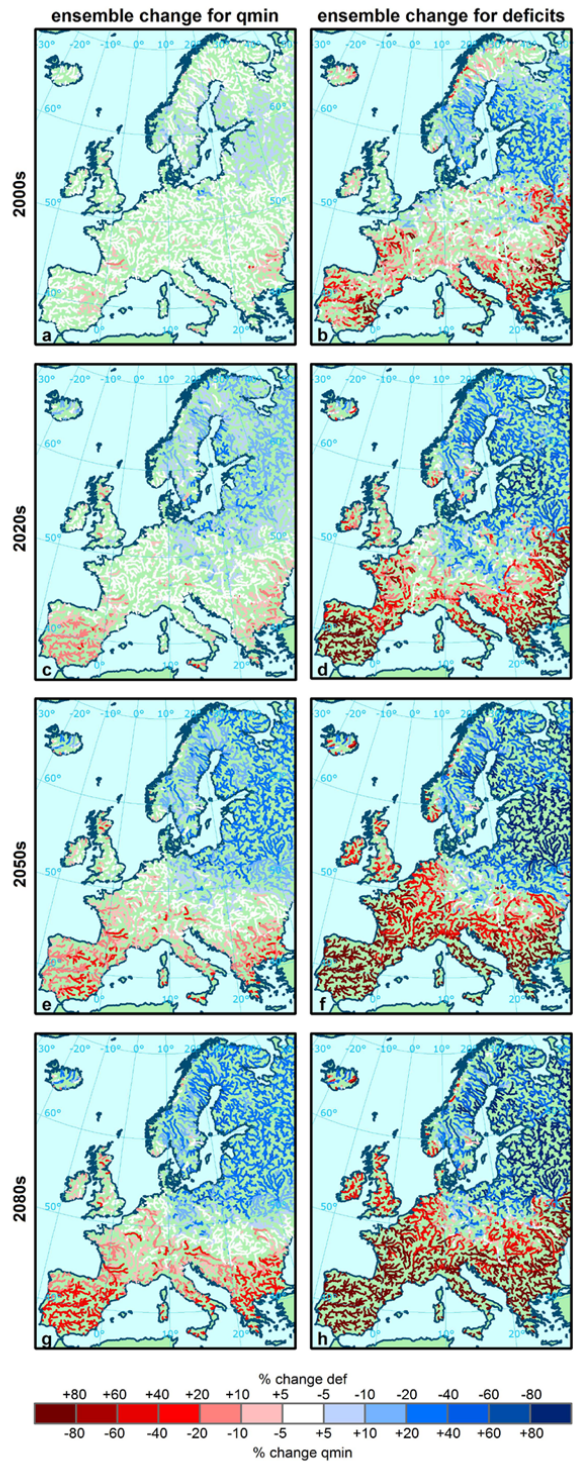
Fig. 8. Ensemble-average change in the 20yr return level minimum flow (left) and deficit volumes (right) due to only climate change between the corresponding time slices and the control period (1961–